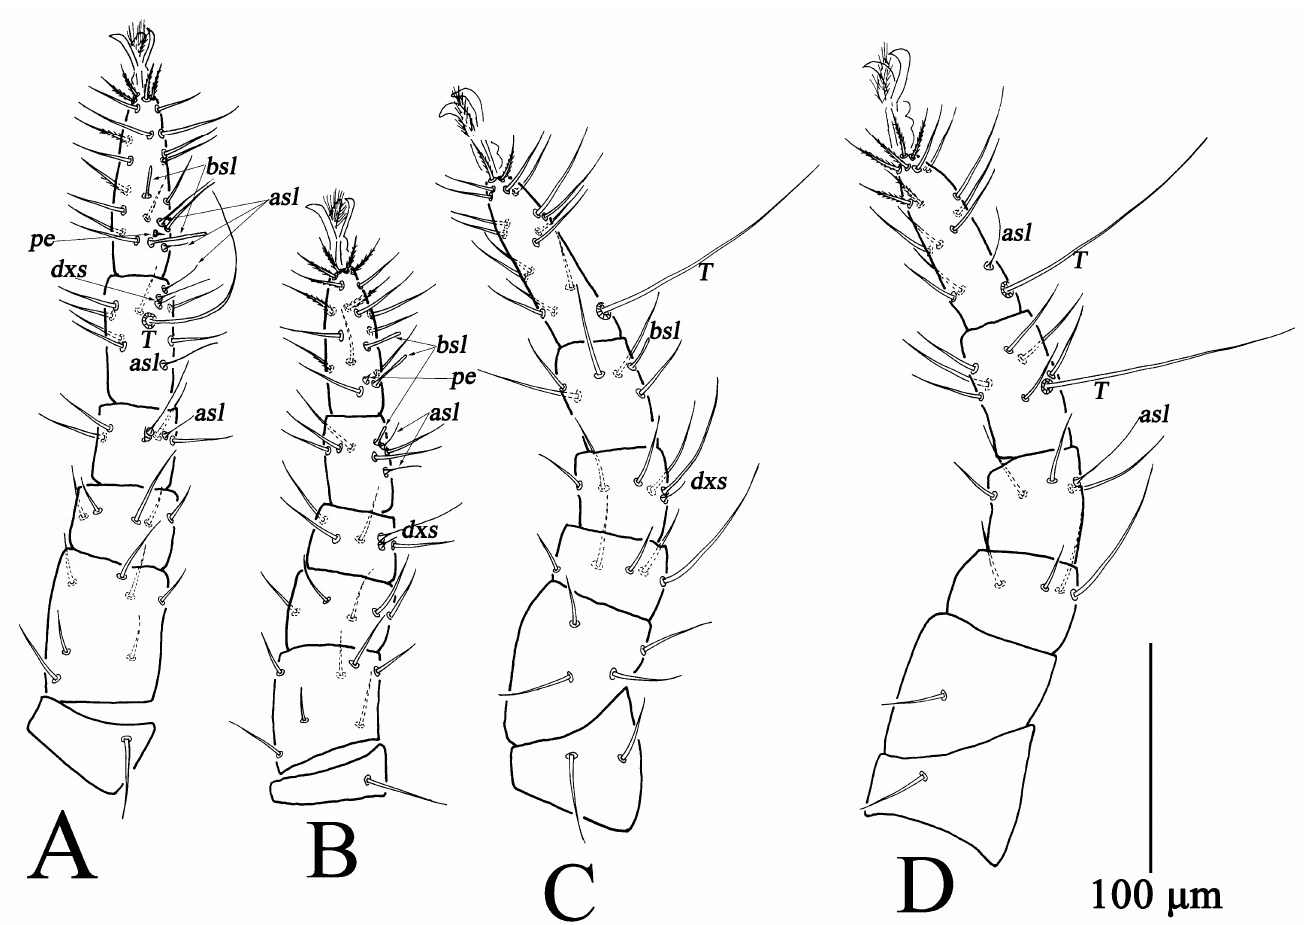
Figure 9. Bdella muscorum , deutonymph: ( A ) Leg I; ( B ) Leg II; ( C ) Leg III; ( D ) Leg IV.